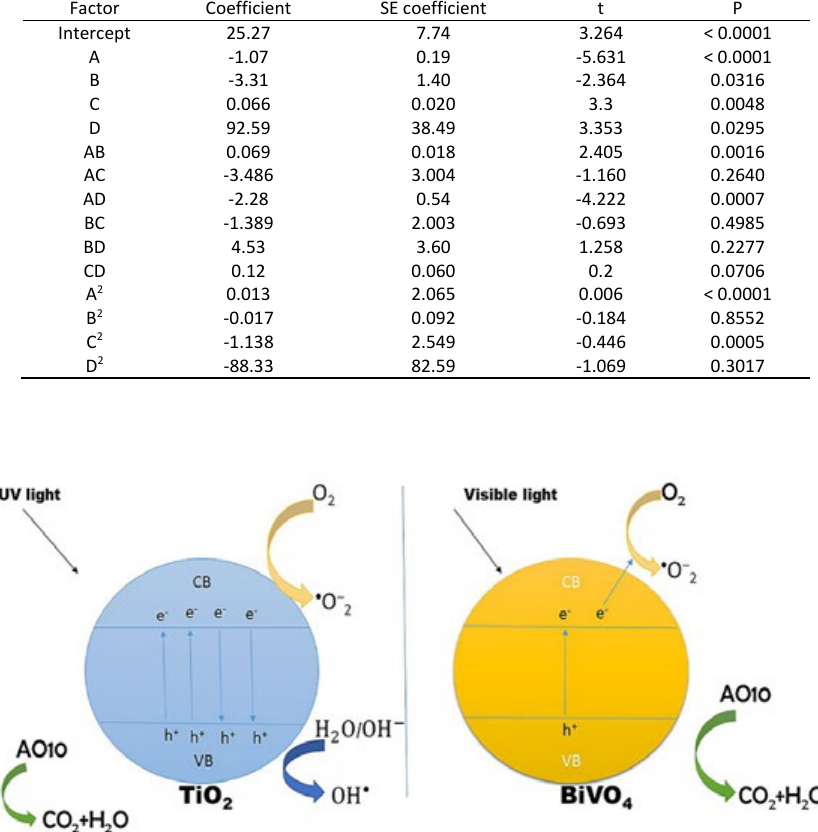
Table 5: Estimated regression coefficients for UV–Vis/BiVO 4 process of AO10 removal Factor